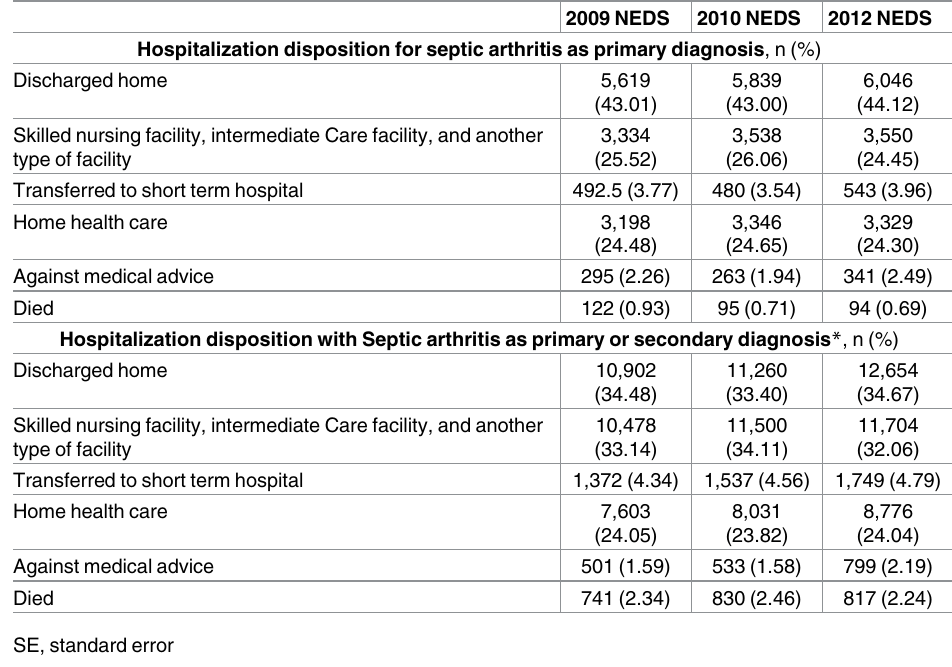
Table 3. Disposition of patients after hospital admission for septic